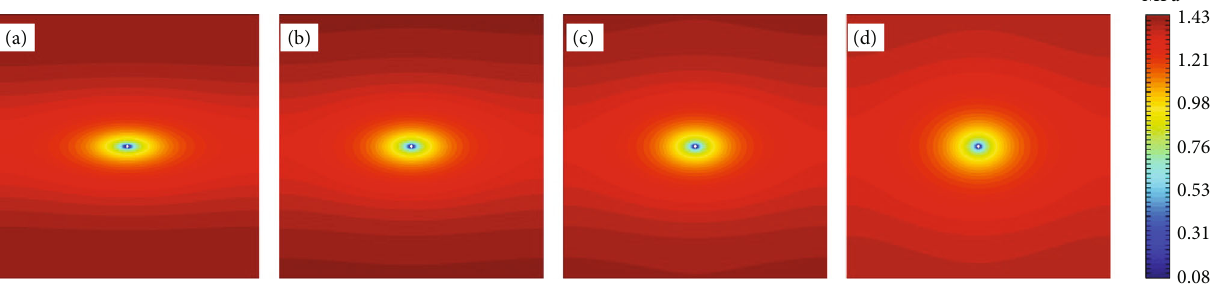
Figure 11: Distribution of gas pressure under di ff erent anisotropy coe ffi cients at 180 days. (a) λ = 0 : 1 , (b) λ = 0 : 2 , (c) λ = 0 : 3 , and (d) λ = 0 : 5